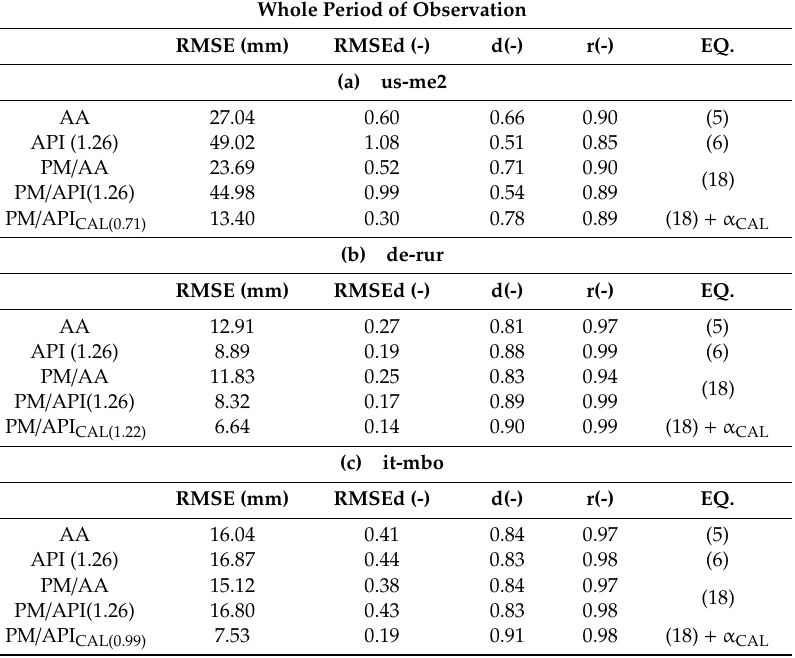
Table 3. Goodness-of-fit indices for the four applied models. Errors are computed on monthly AET time series for the whole period of observation (AA = the advection-aridity method; API (1.26) = the API corrected potential evapotranspiration with α = 1.26; PM / AA = the Penman / advection-aridity threshold model; PM / API(1.26) = the Penman / API corrected potential evapotranspiration threshold model with α = 1.26; PM / API CAL = Penman / API corrected potential evapotranspiration calibrated threshold